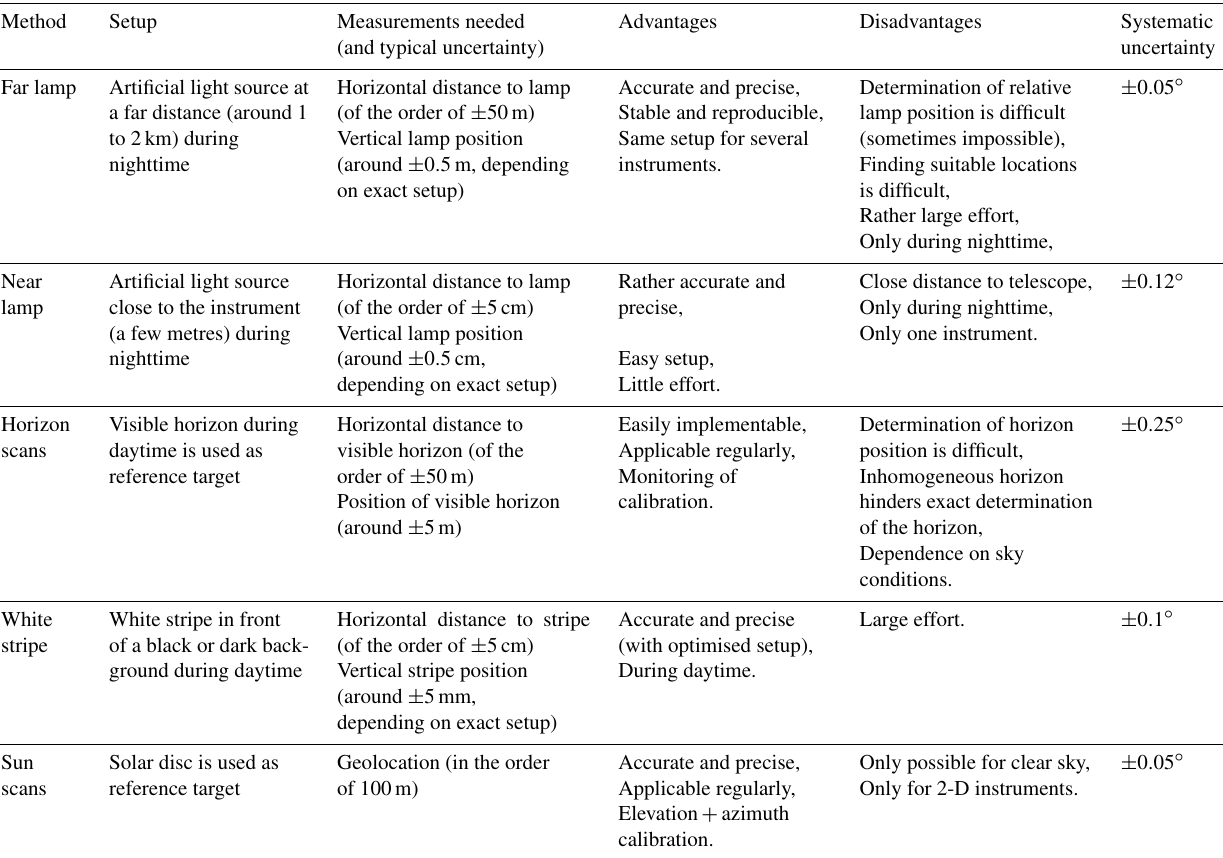
Table 5. Overview on the basic characteristics of the described methods for elevation calibration. The table summarises the basic setup and prerequisites needed (column 2). Column 3 shows properties that have to be measured with their typical (systematic) uncertainties. Note that the uncertainties in this table are typical values and not the exact ones used in this study. Columns 4 and 5 list advantages and disadvantages of the different methods, respectively. Finally, the last column gives uncertainty estimates based on the results from CINDI-2 summarised in this paper. Here, it should be noted that also statistical errors occur, which are usually dominated by the uncertainties of the positioners (see Table A2). These uncertainties are usually between 0.02 and 0.1 ◦ and are similar for all